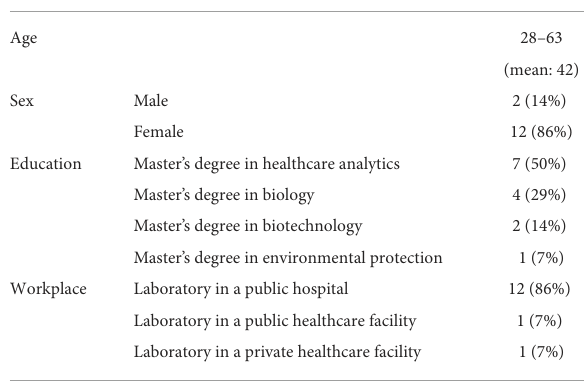
TABLE 1 Description of the surveyed population in stage 1 – qualitative pilot study ( N = 14).